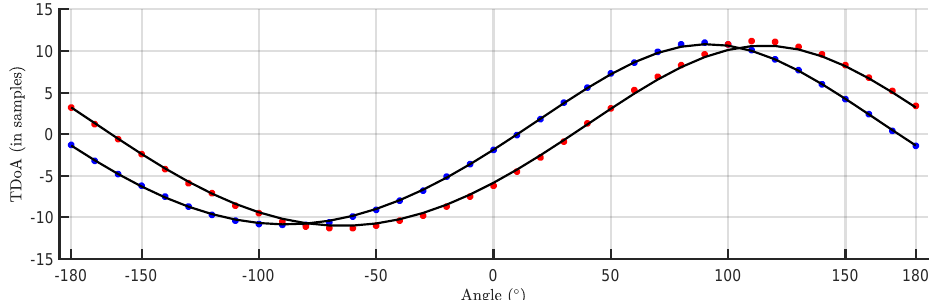
Figure 11. Median of all TDOA versus rotation angle and fitting function. Blue plot corresponds to source 1 and red plot to source